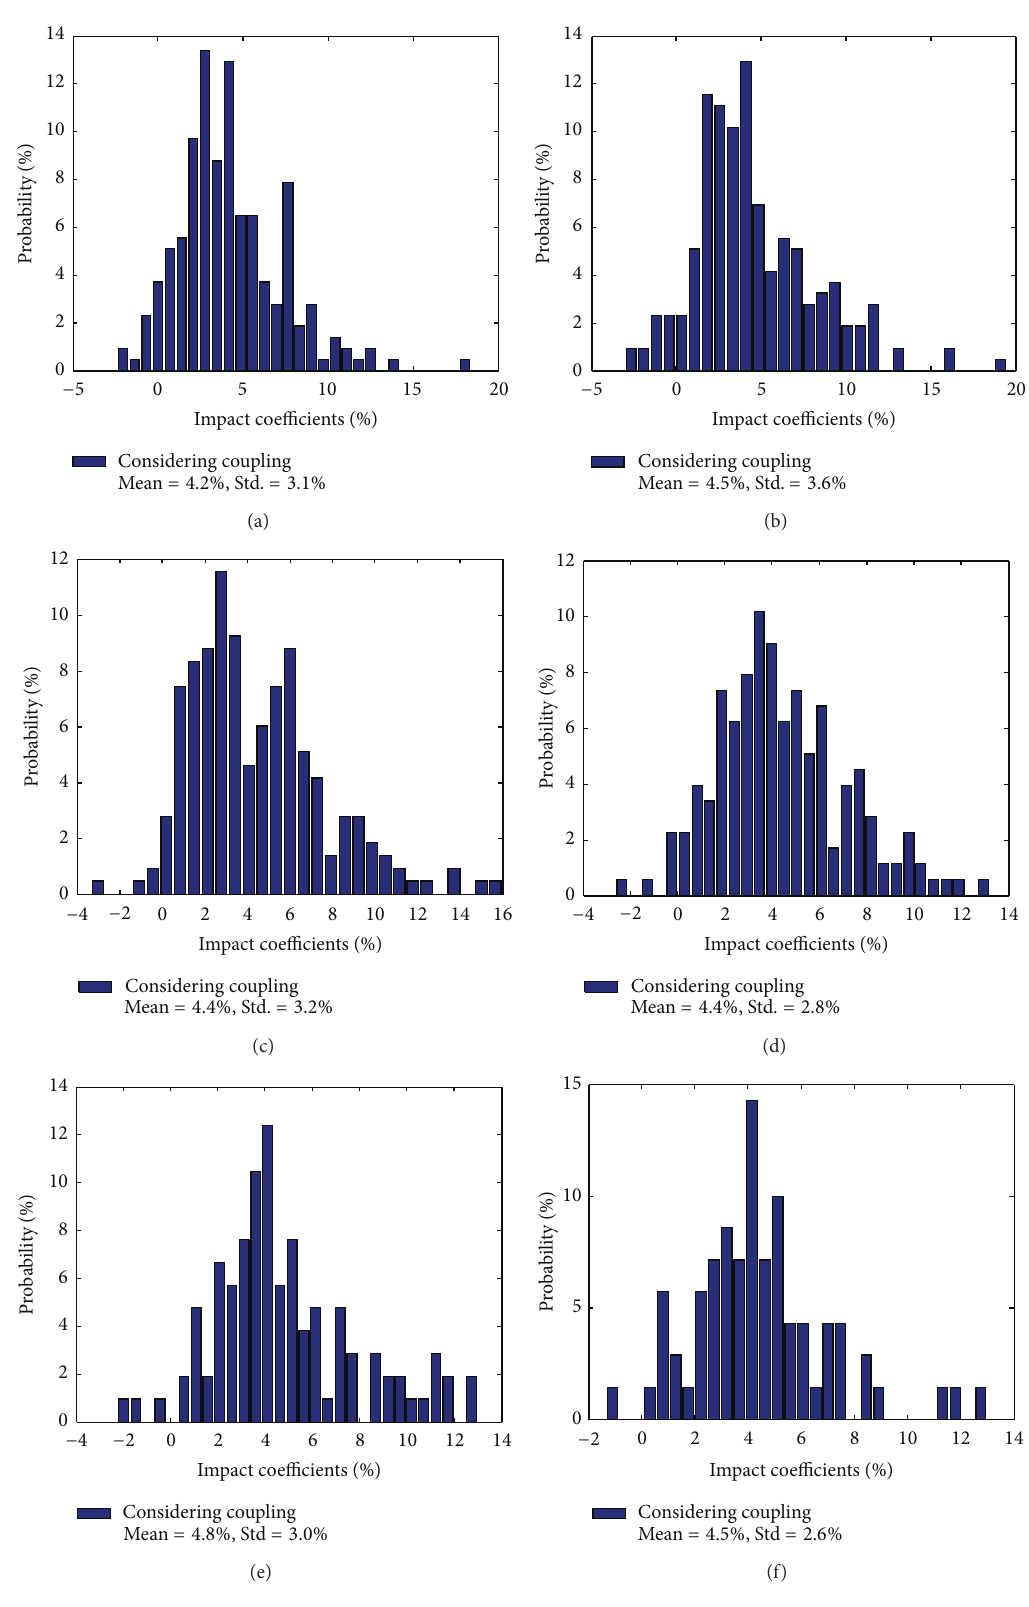
Figure 12: Probabilistic distributions of vertical displacement impact coefficients at point A of the bridge under the action of traffic flows in different time segments: (a) from 00:00 to 05:00; (b) from 06:00 to 11:00; (c) from 12:00 to 17:00; (d) from 18:00 to 23:00; (e) from 09:00